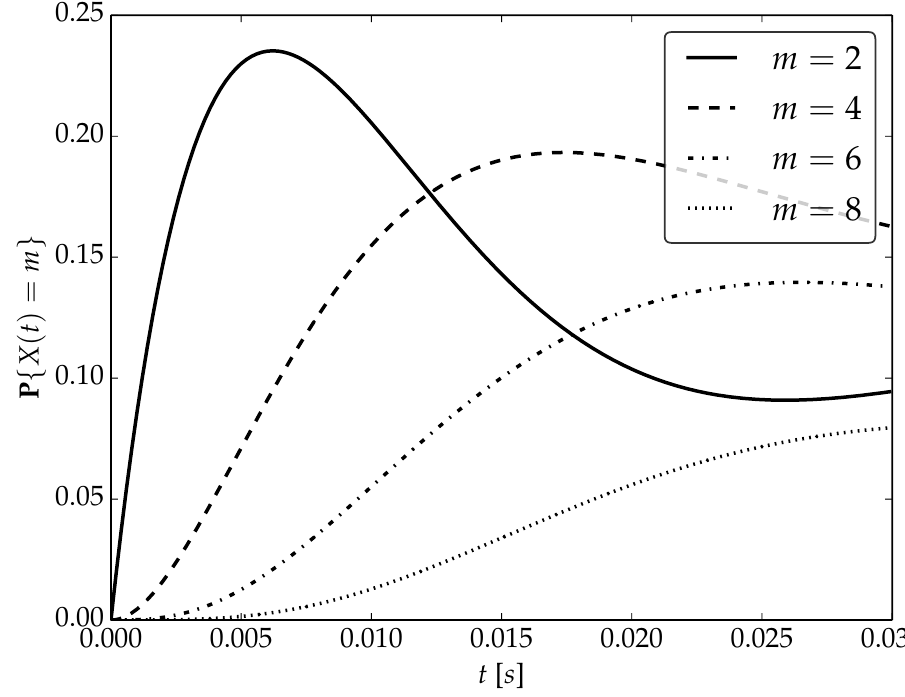
Figure 9. Transient distributions P { X ( t ) = m } for N = 6, batch distribution P 1 and ρ =